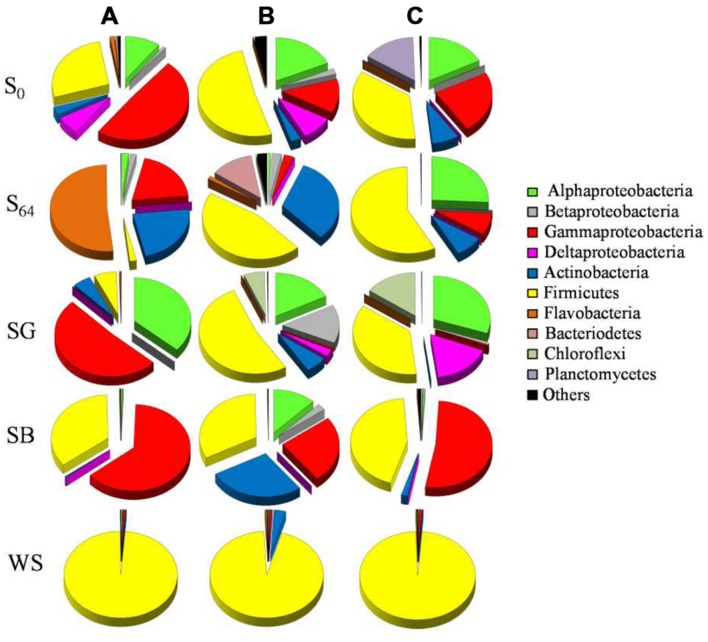
Pie charts depicting the relative abundance (% of total sequences) of bacterial groups in the original soil (S0) and in the soils at the end of the microcosm experiment (S64: untreated soil after 64 days of incubation; SG: sewage sludge treatment; SB: soybean meal treatment; WS: wheat straw treatment). The triplicates of each soil are denoted as (A–C).